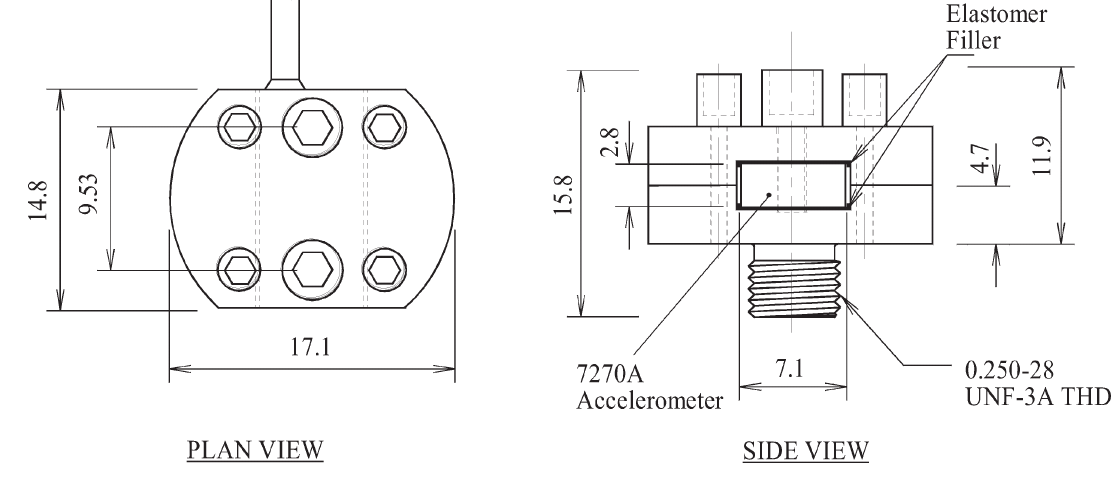
Fig. 5. Detail of the Endevco 7270AM6